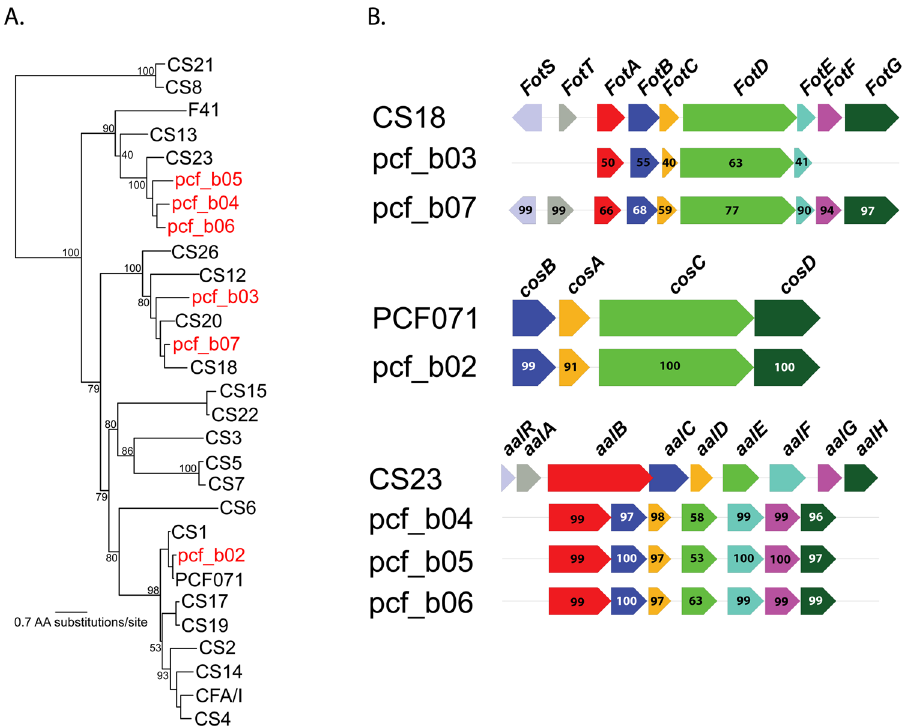
Figure 4. Analysis of novel putative colonization factors (CFs) identified in isolates sequenced in the current study. ( A ) A phylogenetic tree inferred from an alignment of peptide sequences from previously described CF major structural subunits, shown in black, and sequences from new putative CFs, shown in red. Sequences were aligned with MUSCLE 72 and a phylogeny was inferred with RAxML 60 with 100 bootstrap replicates. ( B ) Structural organization of novel putative CFs. Reference CFs were used to organize novel putative CFs. Numbers indicate the percent BLAST identity of protein sequences. The structure of novel putative CFs were identified from Prokka 71